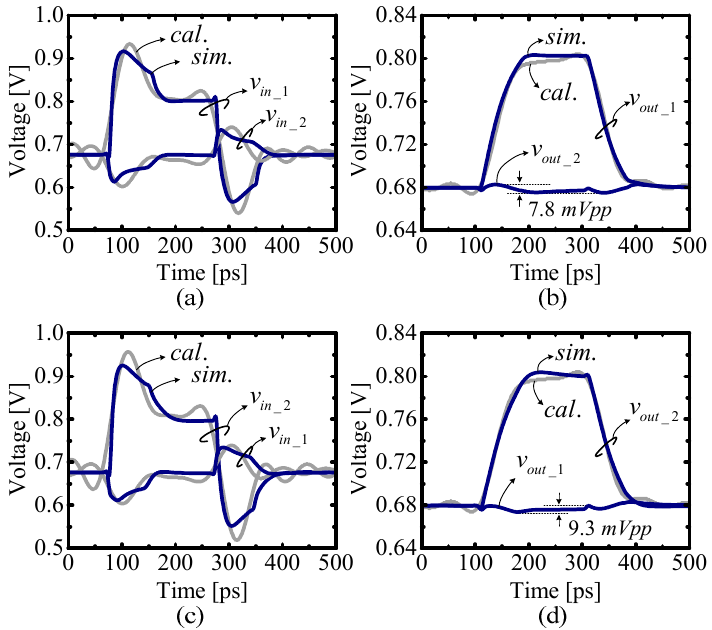
Figure 14. Waveforms comparison. ( a , b ) are the input and output waveforms for { ↑ 0 0} patterns, respectively. ( c , d ) are the input and output waveforms for {0 ↑ 0} patterns, respectively. The gray lines (cal.) are waveforms determined by the proposed technique, and the blue solid lines (sim.) are simulation results obtained by circuit simulation.